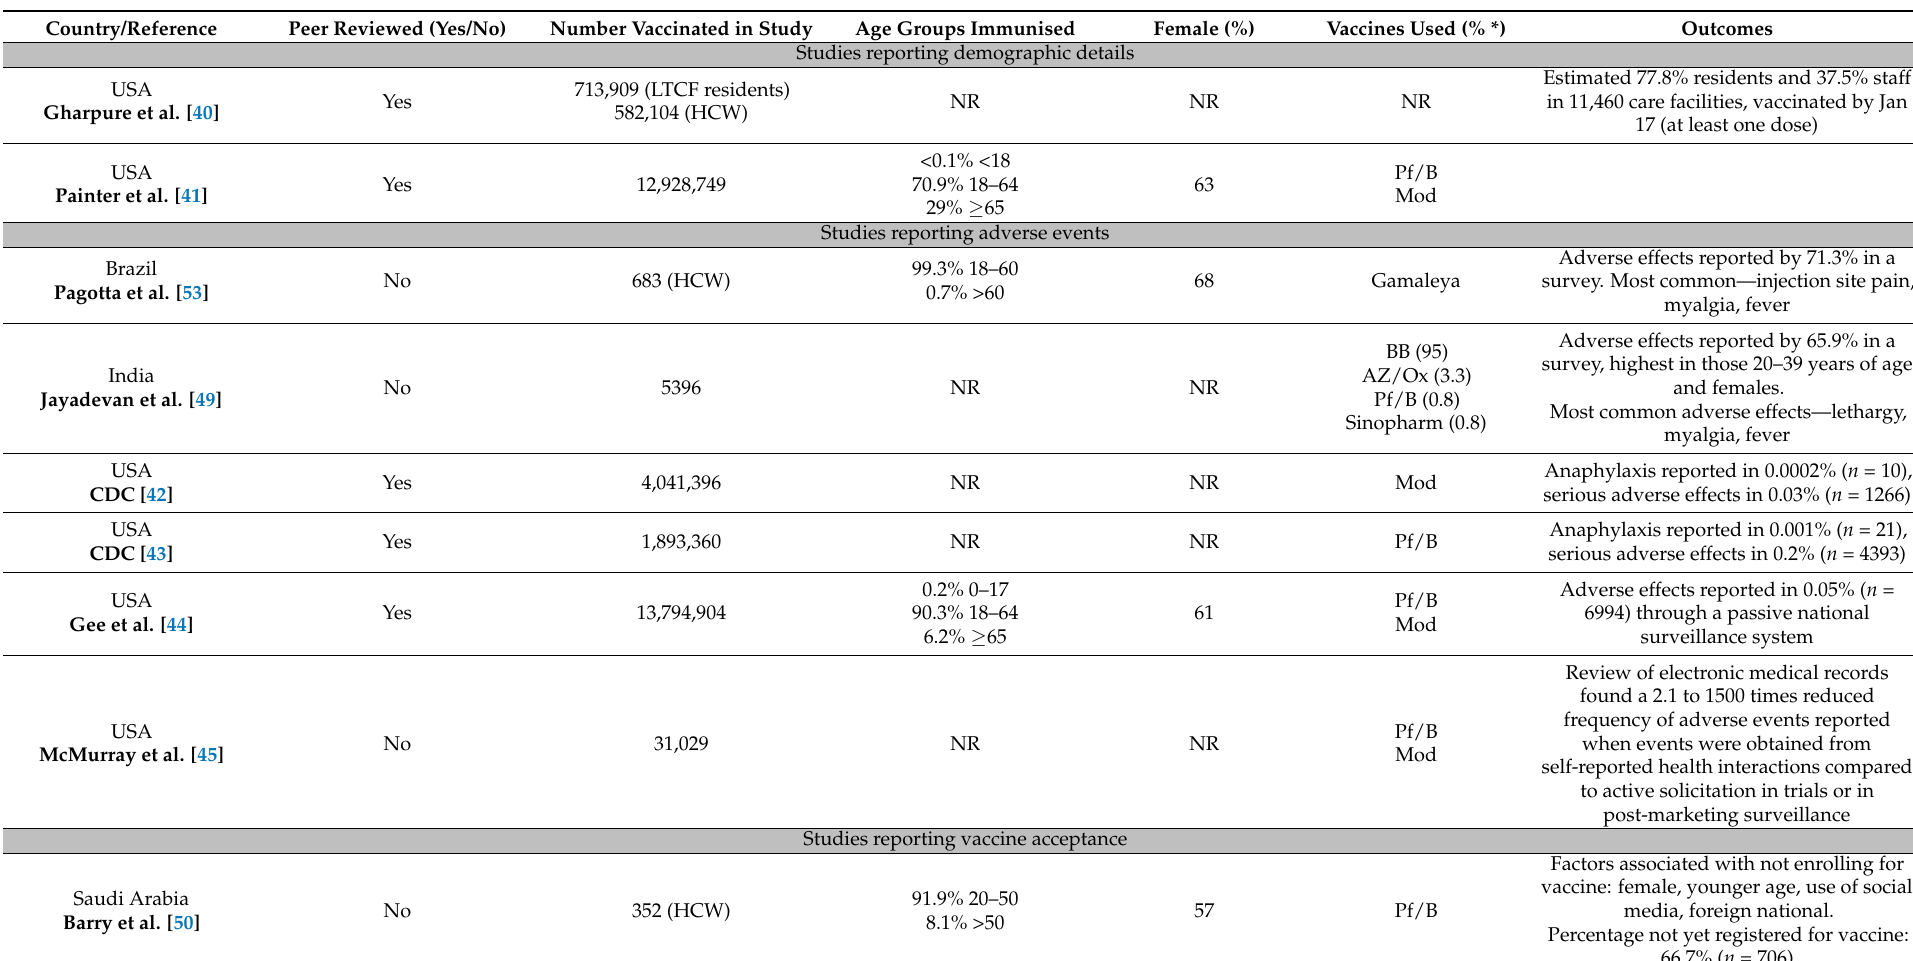
Table 2. Published peer-reviewed and non-peer reviewed articles summarising real-life experience with vaccination against